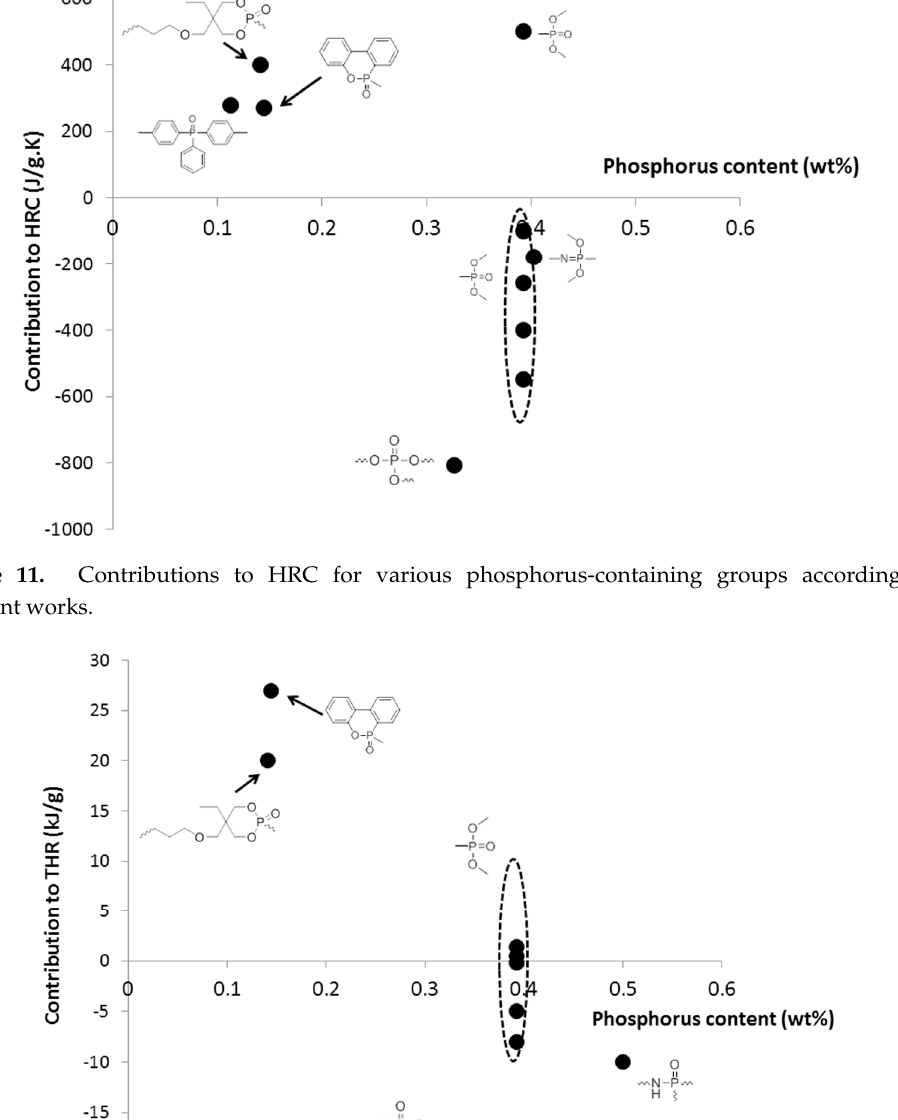
Figure 13. Structure fragmentation of dioxaphosphorinane group into smaller groups.